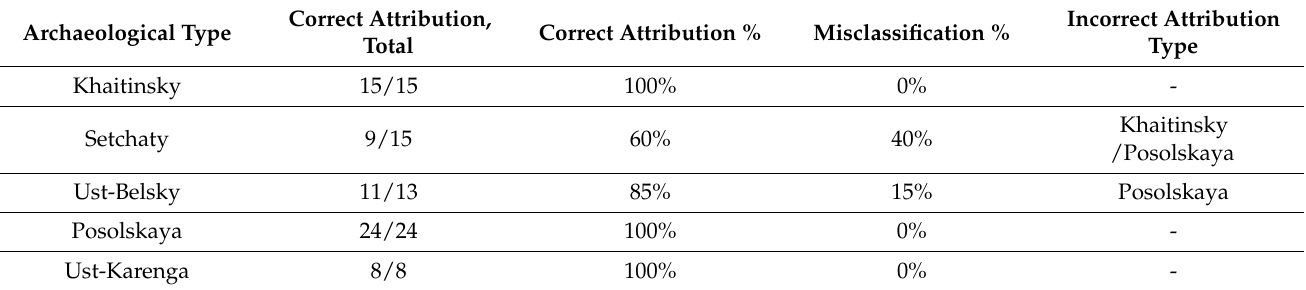
Table 5. Differentiation of ceramic samples by archaeological type based on the results of